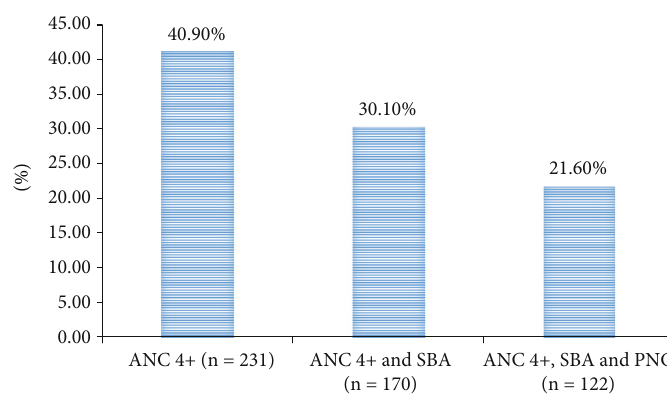
Figure 1: Maternal health services and the continuum of care among women who give births in the last fi ve years, fi ndings from the primary health care project in northwest Ethiopian districts, September 2019 ( n = 565 ).